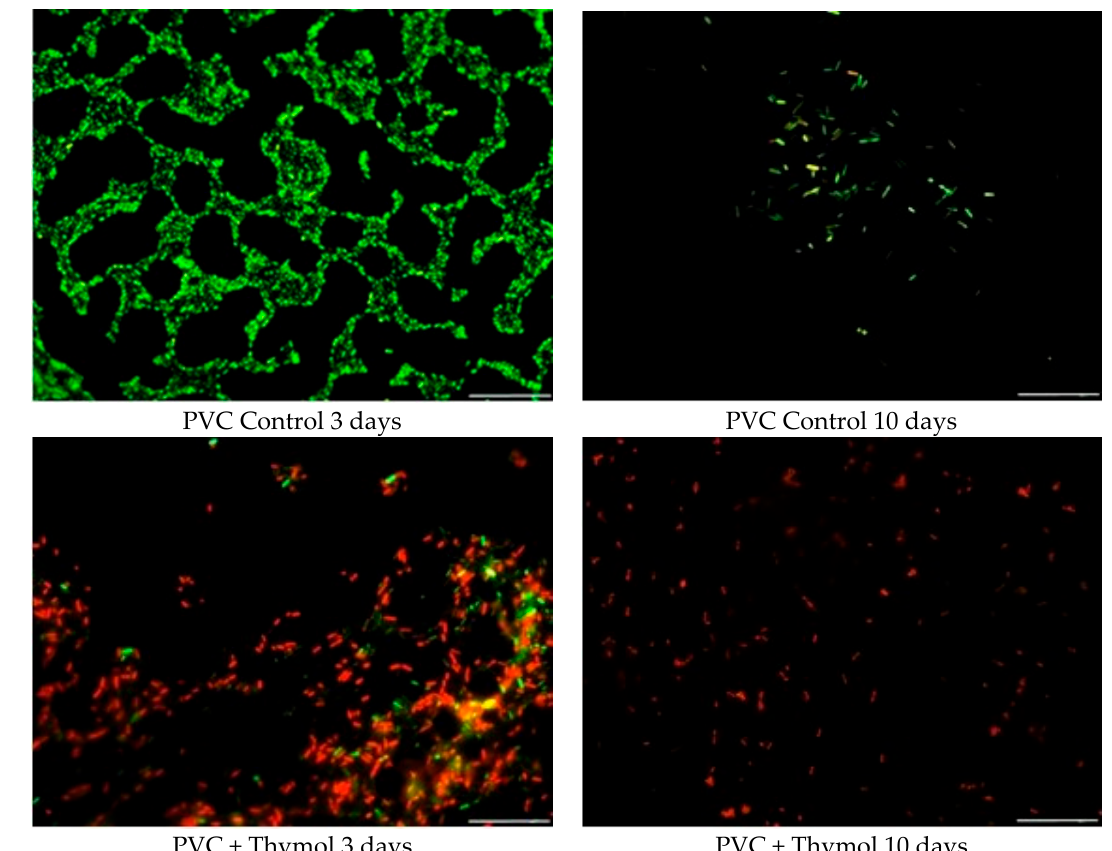
Figure 4. Changes in the quantity and viability of Pseudomonas aeruginosa biofilm on the PVC surface, before and after thymol addition.